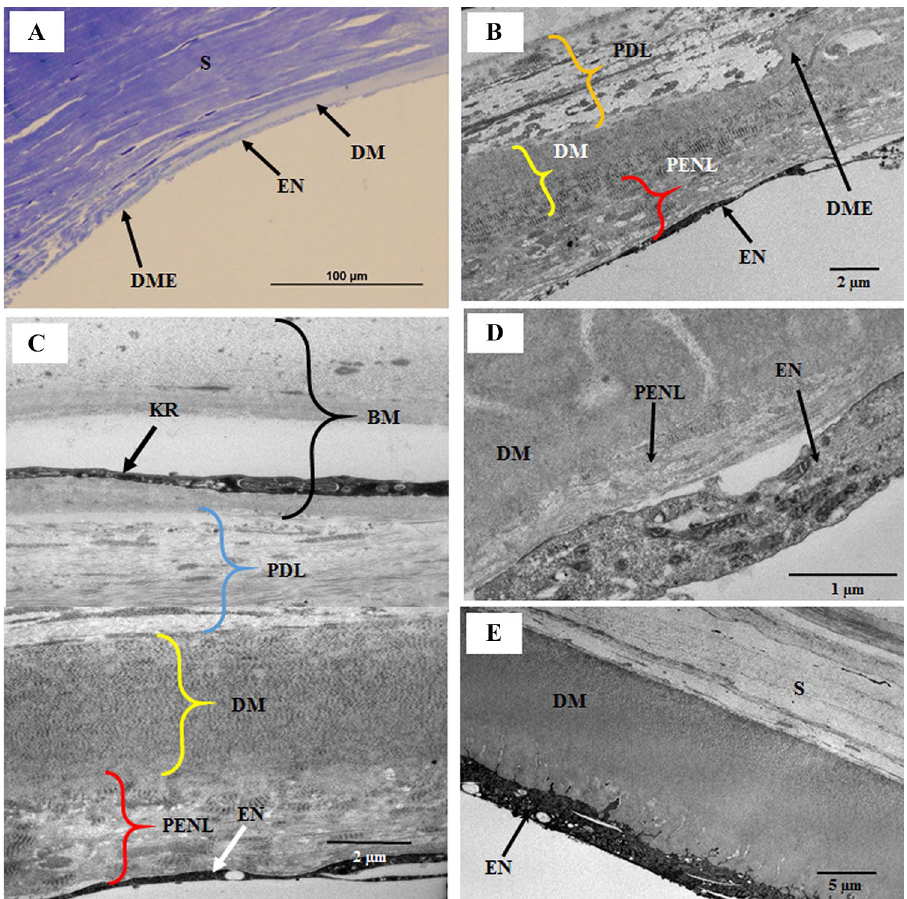
Figure 1. Light and electron micrographs of the peripheral posterior cornea; ( A ) Light micrograph of a part of the peripheral cornea showing the stroma, Descemet’s membrane (DM), endothelium (EN), and the Descemet’s membrane endpoint (DME). ( B ) Part of the peripheral cornea at a distance 105 µm from the DME, showing the DME, EN, pre-endothelial layer (PENL), DM, and pre-DM layer (PDL); ( C ) Part of the peripheral cornea at a distance of 167 µm from the DME, showing the EN, PENL, DM, PDL, and split basement membrane containing a large cell. ( D ) Part of the posterior cornea at the distance of 452 µm from the DME, showing the thinning of the PENL between DM and the EN. ( E ) Part of the posterior cornea at 761.6 nm from the DME, showing the stroma, DM, and EN. No PENL and PDL are observed. BM basement membrane, DM Descemet’s membrane,